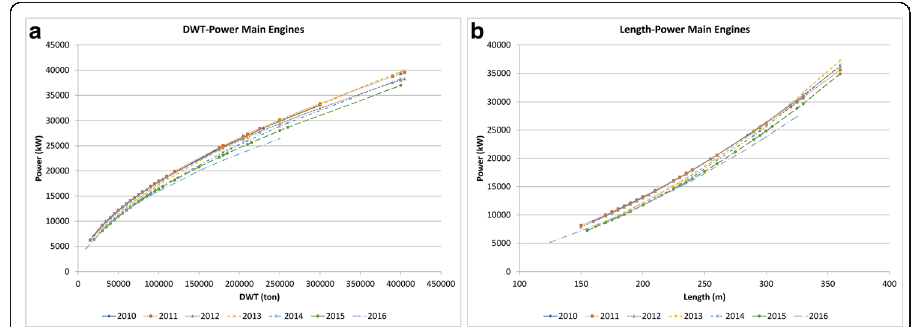
Fig. 2 OLS estimated lines for power main engines based on DWT (left) and Length